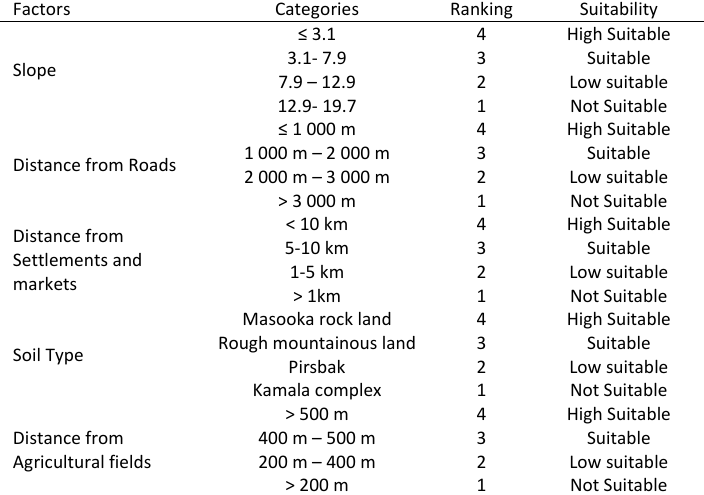
Table 2: Suitability classes of factors for dam site Table 2. Suitability classes of factors for dam